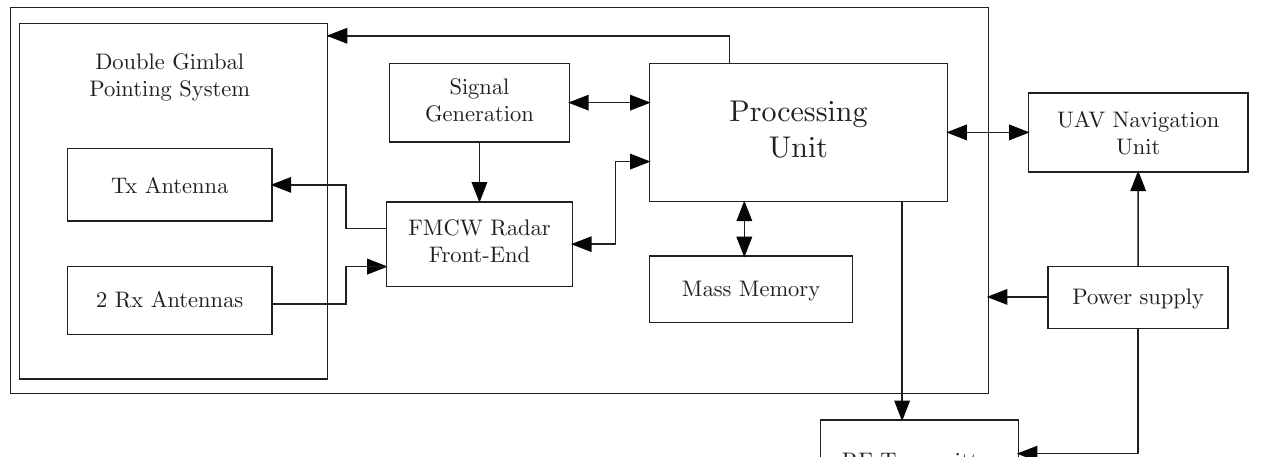
Figure 2. System architecture.